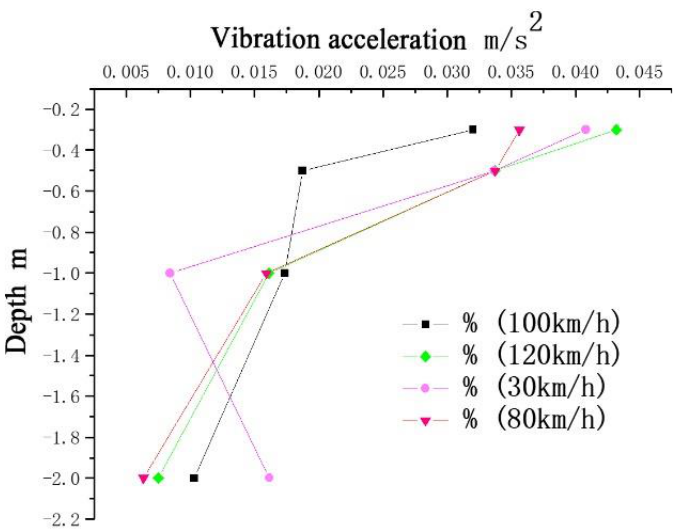
Figure 9. Vibration acceleration–depth distribution rule.